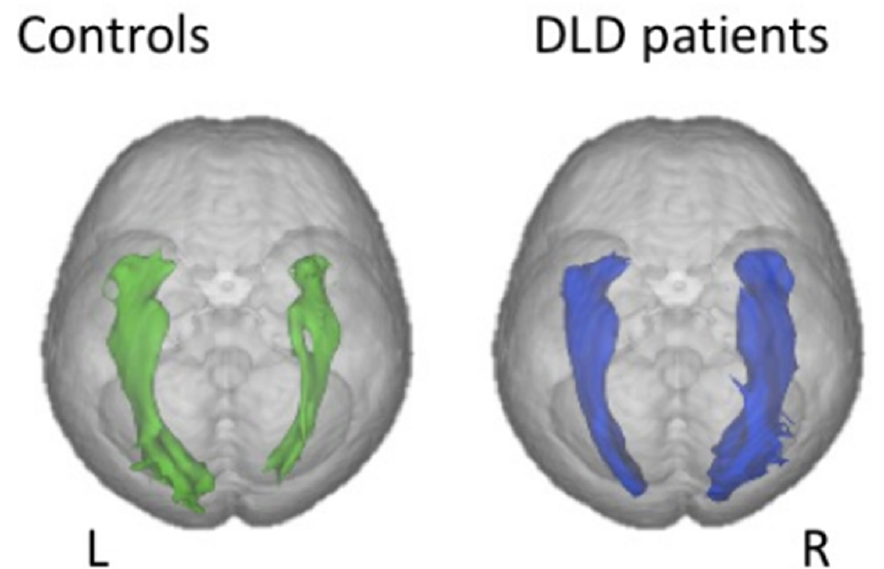
Figure 7. Diffusion MRI findings in children with developmental language disorder (right) compared to normal controls. Reversed rightward volume asymmetry in the IFOF (inferior fronto-occipital fasciculus). From [81]